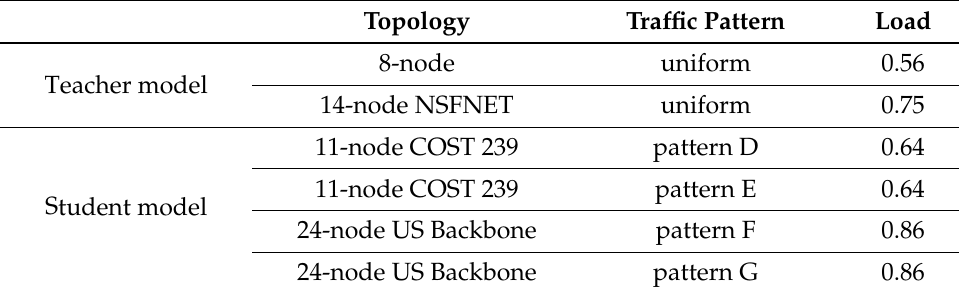
Table 6. Traffic loads for all traffic patterns in Section 5.4.